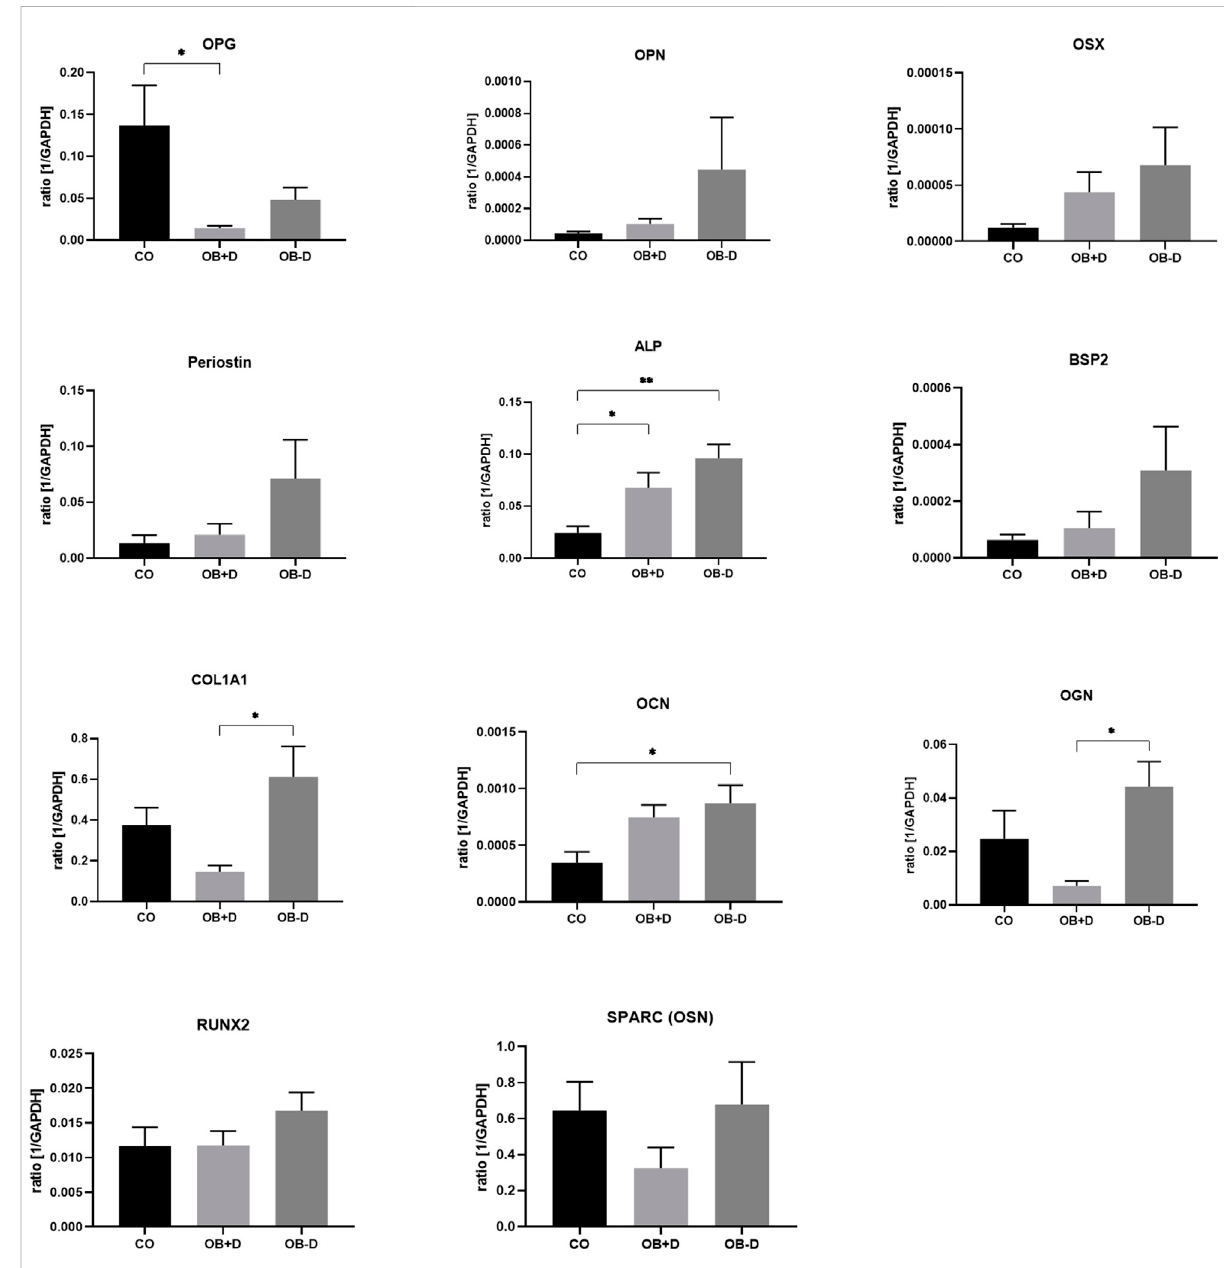
FIGURE 3 Expression of osteogenic marker genes by JPCs cultured for 15 days with control (CO) and osteogenic medium with (OB+D) and without dexa (OB − D).Mean±SEM valuesofmRNAcopynumbersnormalizedbythehousekeepinggene(GAPDH) werecalculated andcompared usingone-way ANOVA and Tukey ’ s multiple comparison test (n = 7, * = p < 0.05, ** = p <